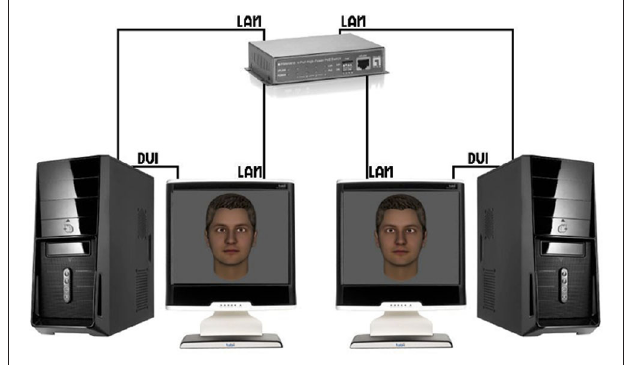
FIGURE 3 | Dual eyetracking setup. Two eyetracking devices are linked via a local area network (LAN), which allows to simultaneously measure two study participants engaged in a mediated gaze-based interaction (each participant is represented by a virtual character for the respective other). Taken from: Barisic et al.